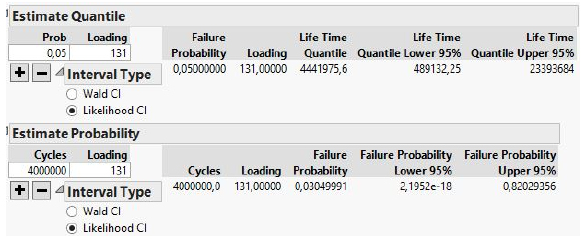
Figure 11. Custom estimate for Material#2.